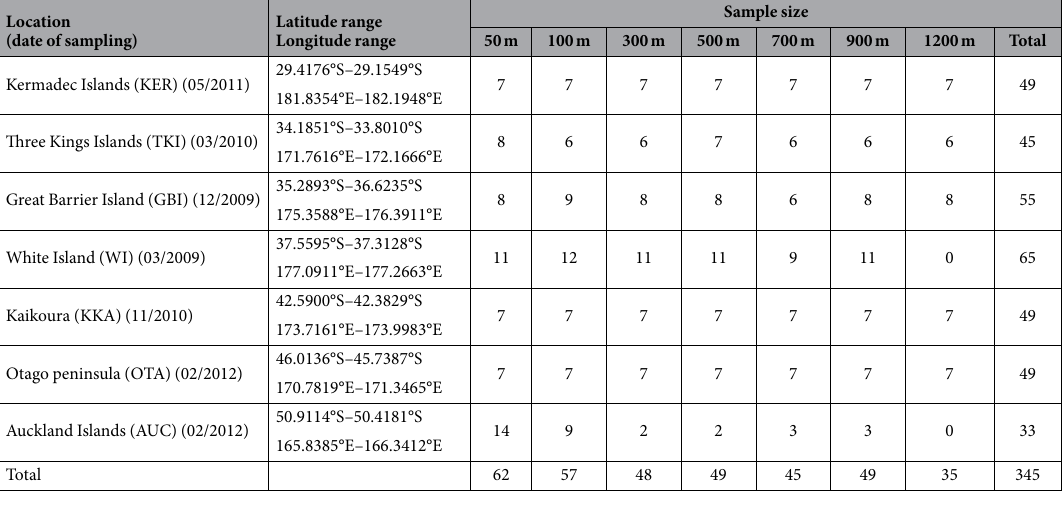
Table 2. Range in latitude and longitude for deployments obtained at each of the seven locations and the number of baited remote underwater stereo-video (stereo-BRUVs) deployments obtained at each depth within each